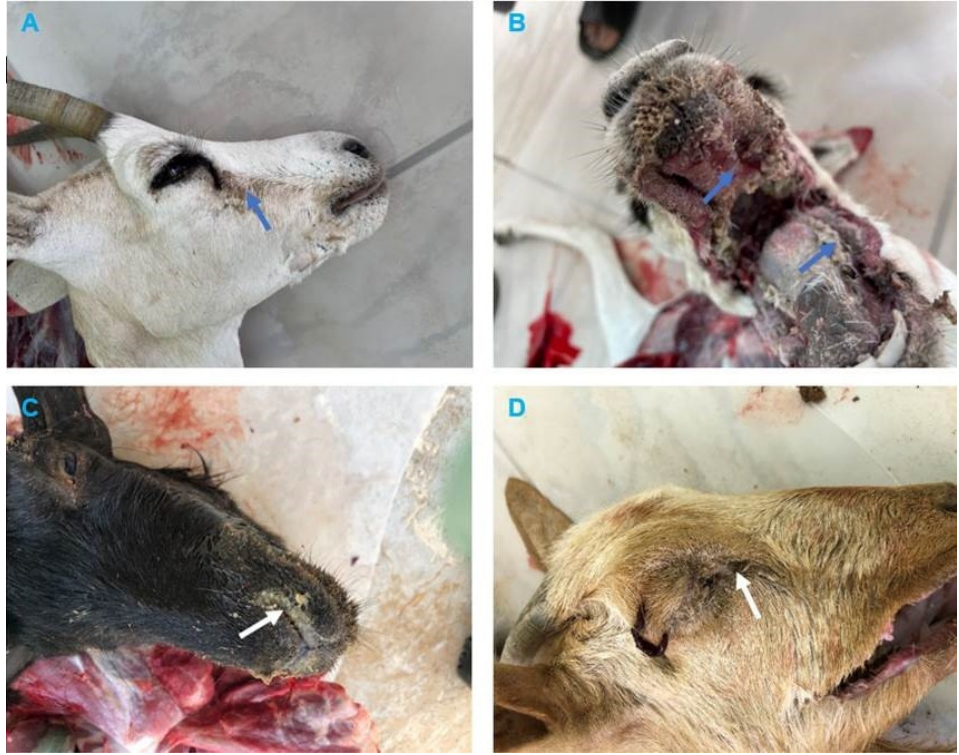
Figure 2. Clinical findings of peste des petits ruminants (PPR) in Dama Gazelle and Goats. ( A ) Dama Gazelle, showing ocular discharges (blue arrow). ( B ) Dama Gazelle, mouth lesions showing erosion on the buccal cavity, gums, and dental pad with whitish covering materials (blue arrows). ( C ) Goat, showing mucopurulent nasal discharges (white arrow). ( D ) Goat, showing conjunctivitis with purulent ocular discharges, the hair below the eyes matting together the eyelids (white arrow).